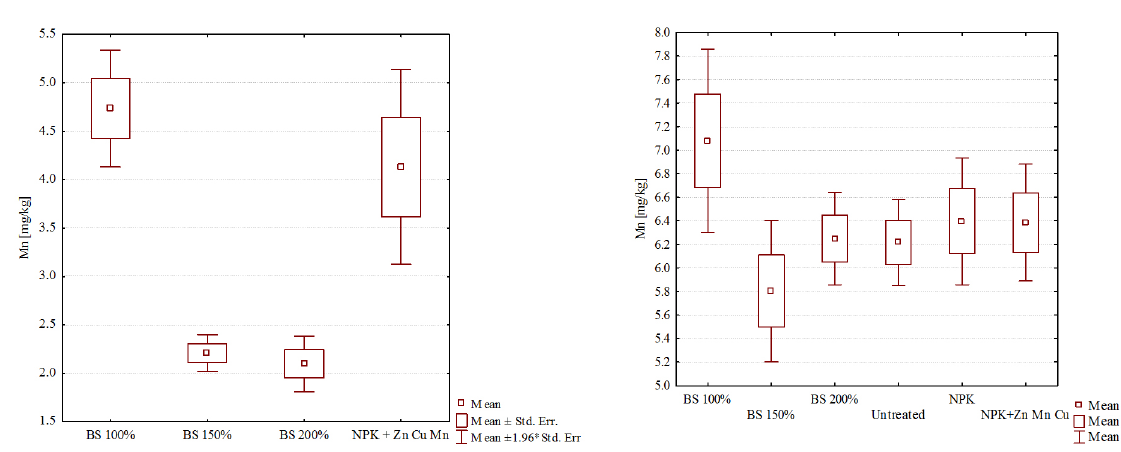
Figure 3: Transfer Factor for Mn.